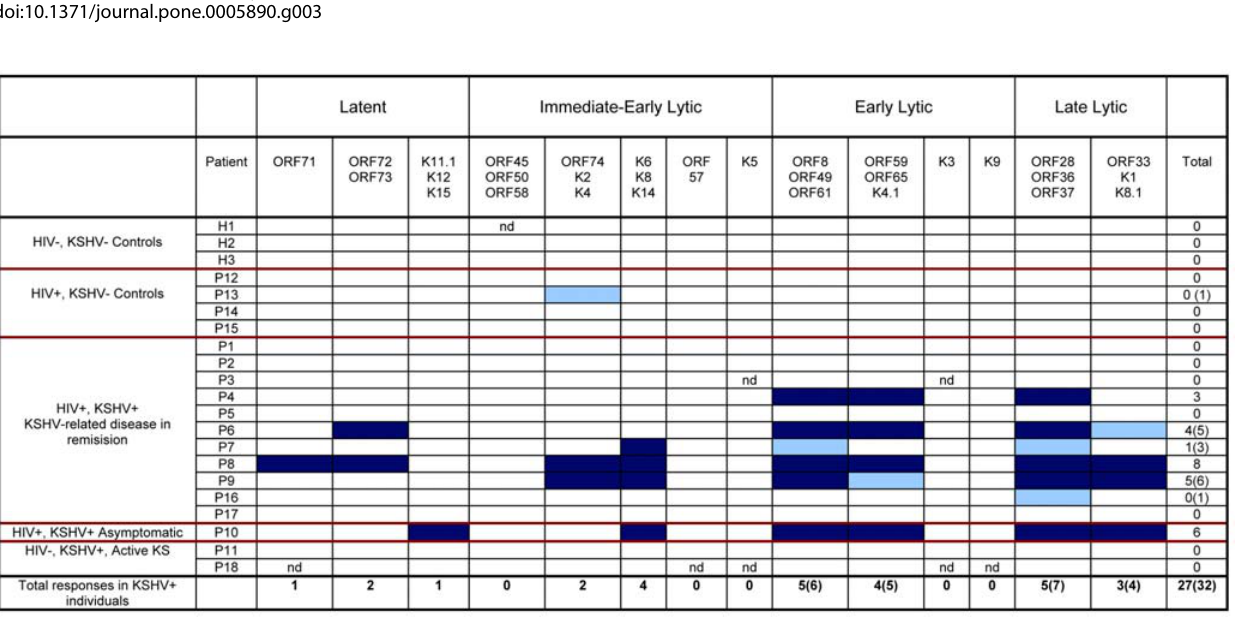
Figure 3. T-cell proliferation responses to transduced moDCs. (a) Gating strategy for T-cell proliferation response assays. Gates are set on the live T lymphocyte population (left panel) and CD8 + cells (middle panel), and the proportion of proliferating cells is taken as the percentage of CFSE- low cells in the bottom two quadrants (right panel). For CD4 responses, R2 is readjusted over the CD8-low cells. (b) Example of CD8 responses to moDCs transduced with each KSHV gene or group of genes from one study participant (P7; HIV + , KSHV + , history of KSHV-related disease, in remission). Bar graphs show the proportion of CFSE-low cells in response to each gene or group of genes (with the background response to moDCs transduced with the empty pSIN vector subtracted). Mean of triplicates and standard deviations are shown. Two stars indicate a response that was considered to be positive; one star indicates a response that was considered to be borderline positive according to the criteria described in Materials and Methods. Flow cytometry histograms show examples of strong (top), medium (middle) and negative (bottom) CD8 responses to different KSHV antigens from the same study participant (P7). In all histograms, grey shading represents CD8 T cells cultured with moDCs transduced with the empty pSIN vector and black lines represent CD8 T cells cultured with moDCs transduced with different KSHV antigens. (c) Same as for (b), but showing CD4 responses from the same study participant (P7).